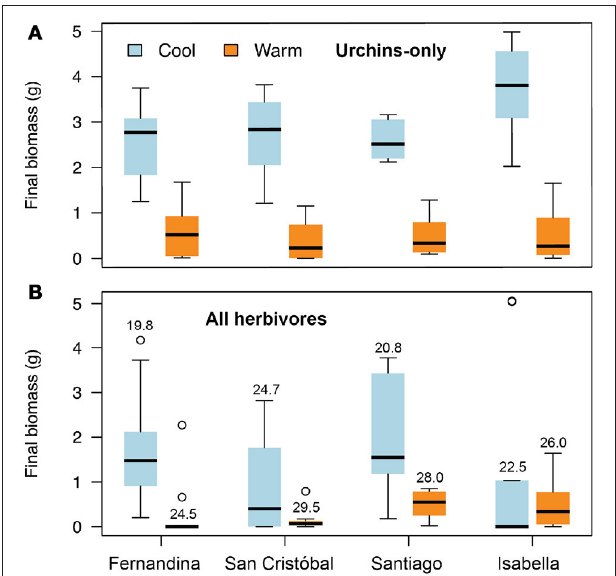
FIGURE 2 | Effects of season (temperature) and site on the grazing rate of Ulva by urchins (A) and all herbivores (B) . Solid black midlines are median values, the upper and lower limits of the box indicate the third and first quartiles, and the circles are outliers. Values above the boxes in the lower plot are the mean temperature ( ◦ C) during both grazing assays (values also apply to the urchin-only assays) at the four sites during the two seasons.